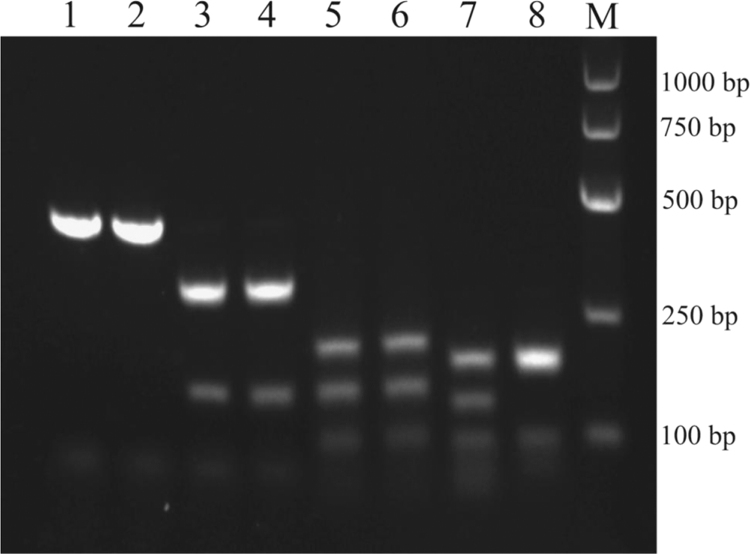
PCR-RFLP profiles of the gyrA gene identified in the 90 Klebsiella isolates using HincII, TaqI, and HaeIII. Lane 1, 3, 5, 7 for KpI (89 isolates) and lanes 2, 4, 6, 8 for KpIII (one isolate). Lanes 1 and 2, the 441-bp PCR product of the gyrA gene. Lanes 3 and 4, HincII restriction profiles (298- and 143-bp fragments). Lanes 5 and 6, TaqI restriction profiles (197-, 142-, and 93-bp fragments). Lane 7, HaeIII restriction profile (175-, 129-, 92-, and 45-bp fragments). Lane 8, HaeIII restriction profile (175-, 174-, and 92-bp fragments). M, molecular size marker.